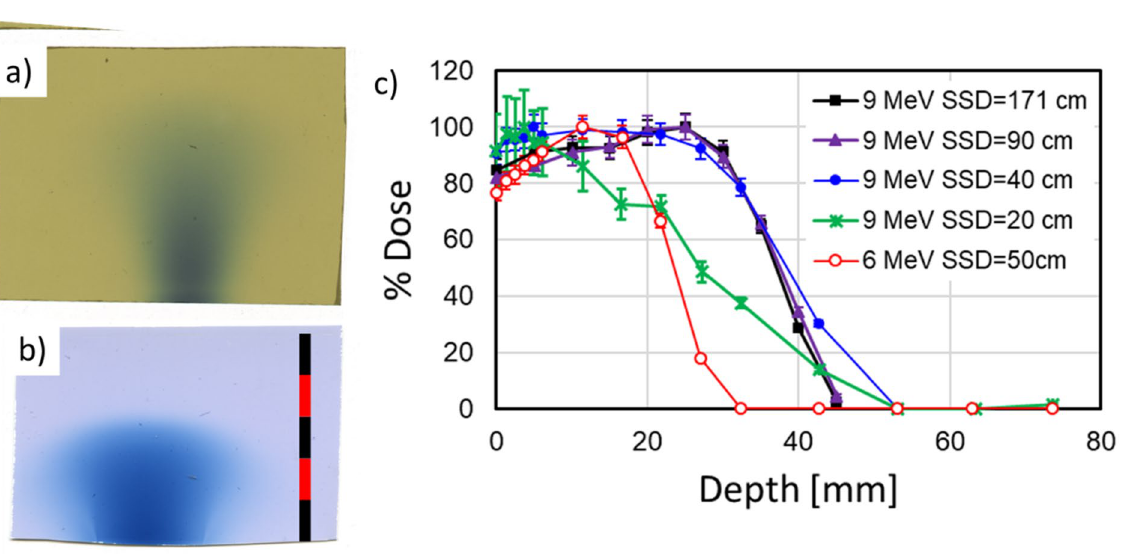
Figure 9. Percent depth dose measurement. ( a )EBT3 and ( b ) OC1 film irradiated parallel to 9 and 6 MeV beams, respectively. Scale bar is 5 × 1 cm. ( c ) dose evaluated from EBT3 film irradiated perpendicular to the beam within a water equivalent polystyrene phantom. 6 MeV: red—SSD = 50 cm; 1 pulse; peak dose 7.7 Gy; 9 MeV beams: green—SSD = 20 cm, 3 pulses, peak dose: 9 Gy; blue—SSD = 40 cm, 30 pulses, peak dose 8.5 Gy; purple—SSD = 90 cm, 200 pulses, peak dose 8 Gy; black—SSD = 171 cm 926 pulses, peak dose 7.6